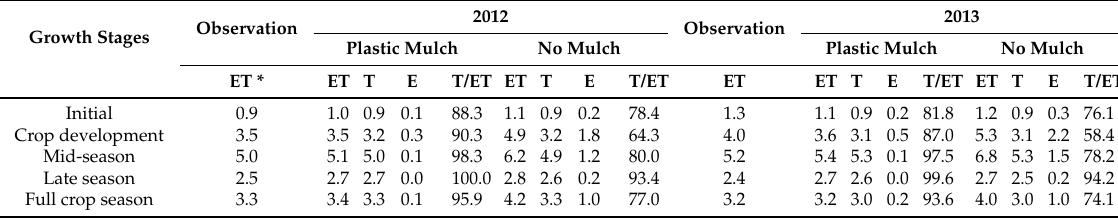
Table 6. ET c act and their components for different growth